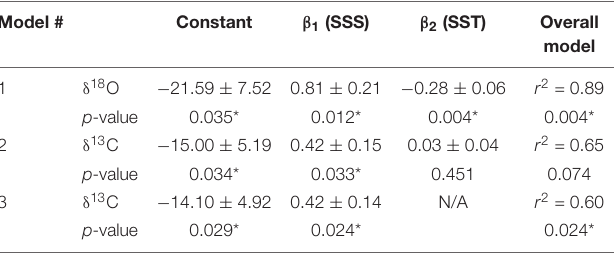
) from sea surface temperature (cid:104)